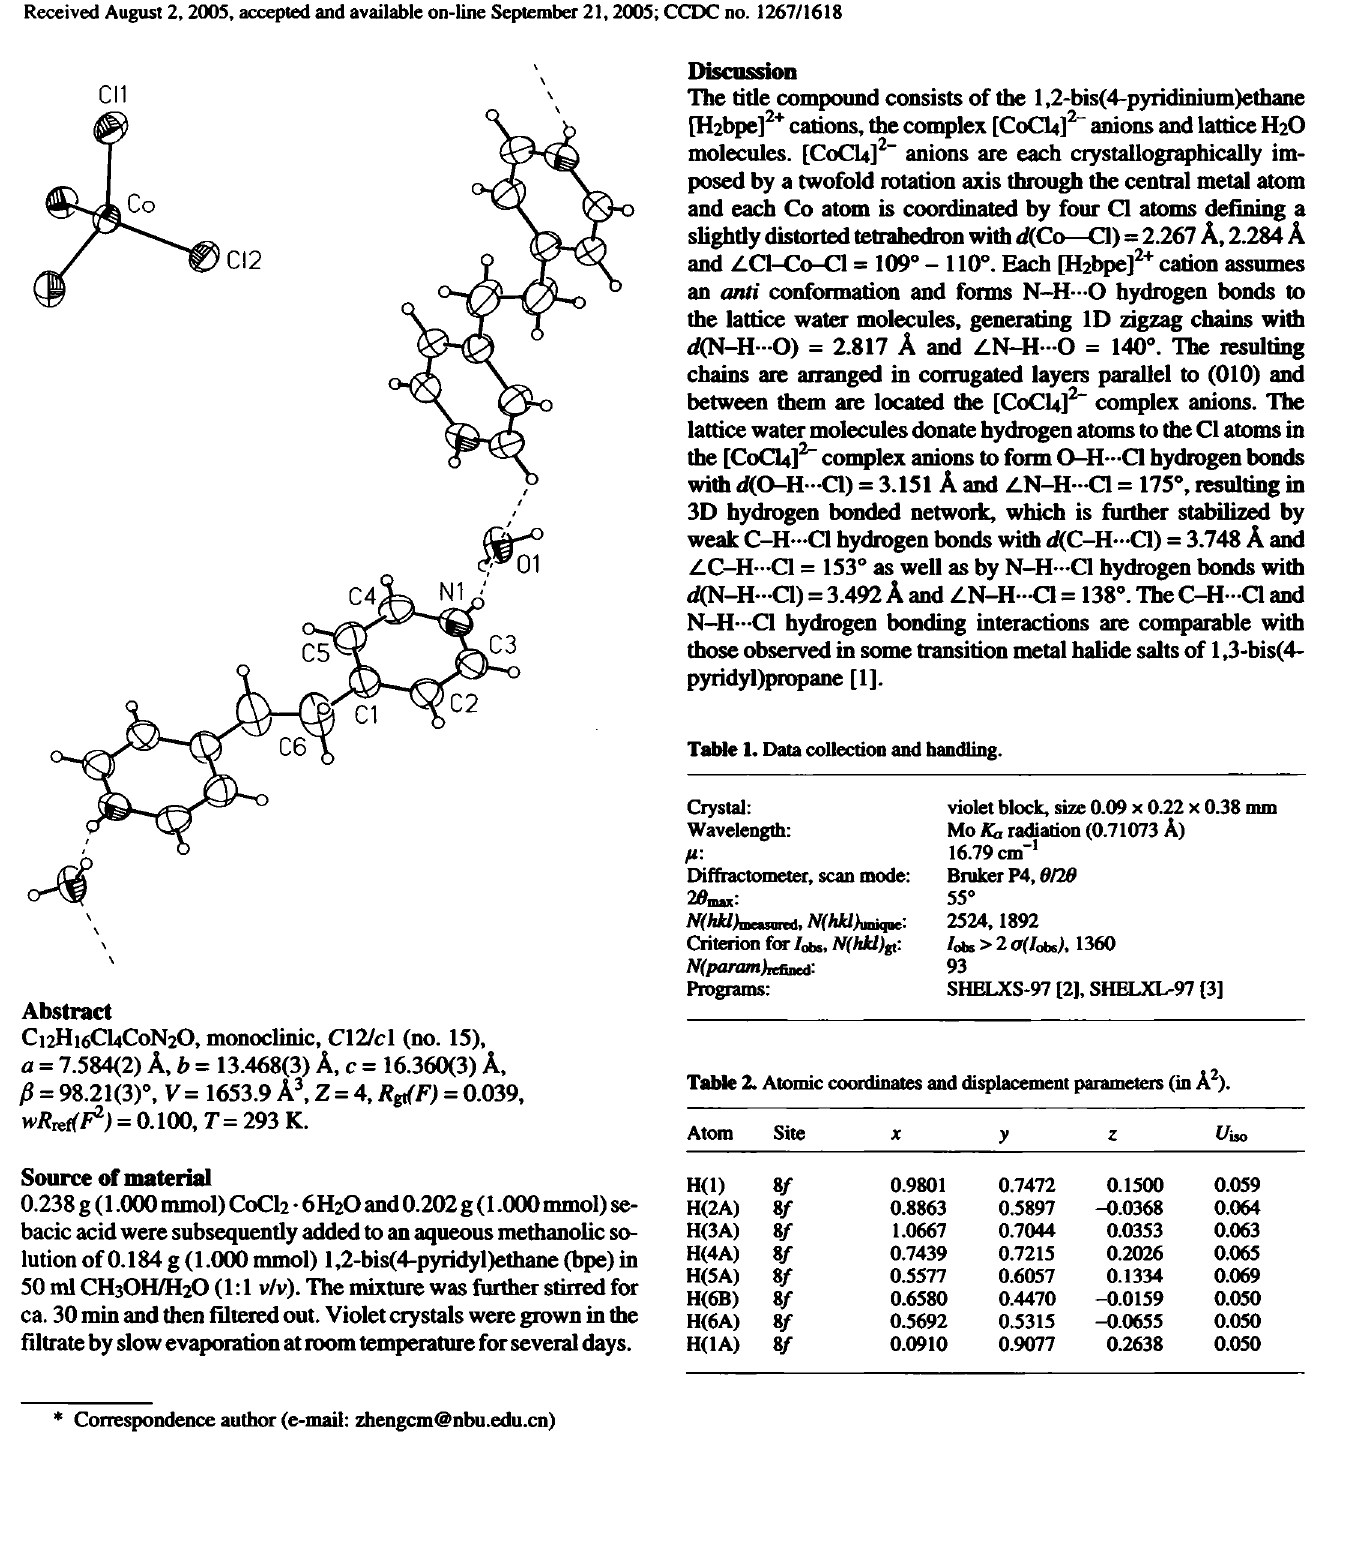
Table 2. Atomic coordinates and displacement parameters (in Ä 2